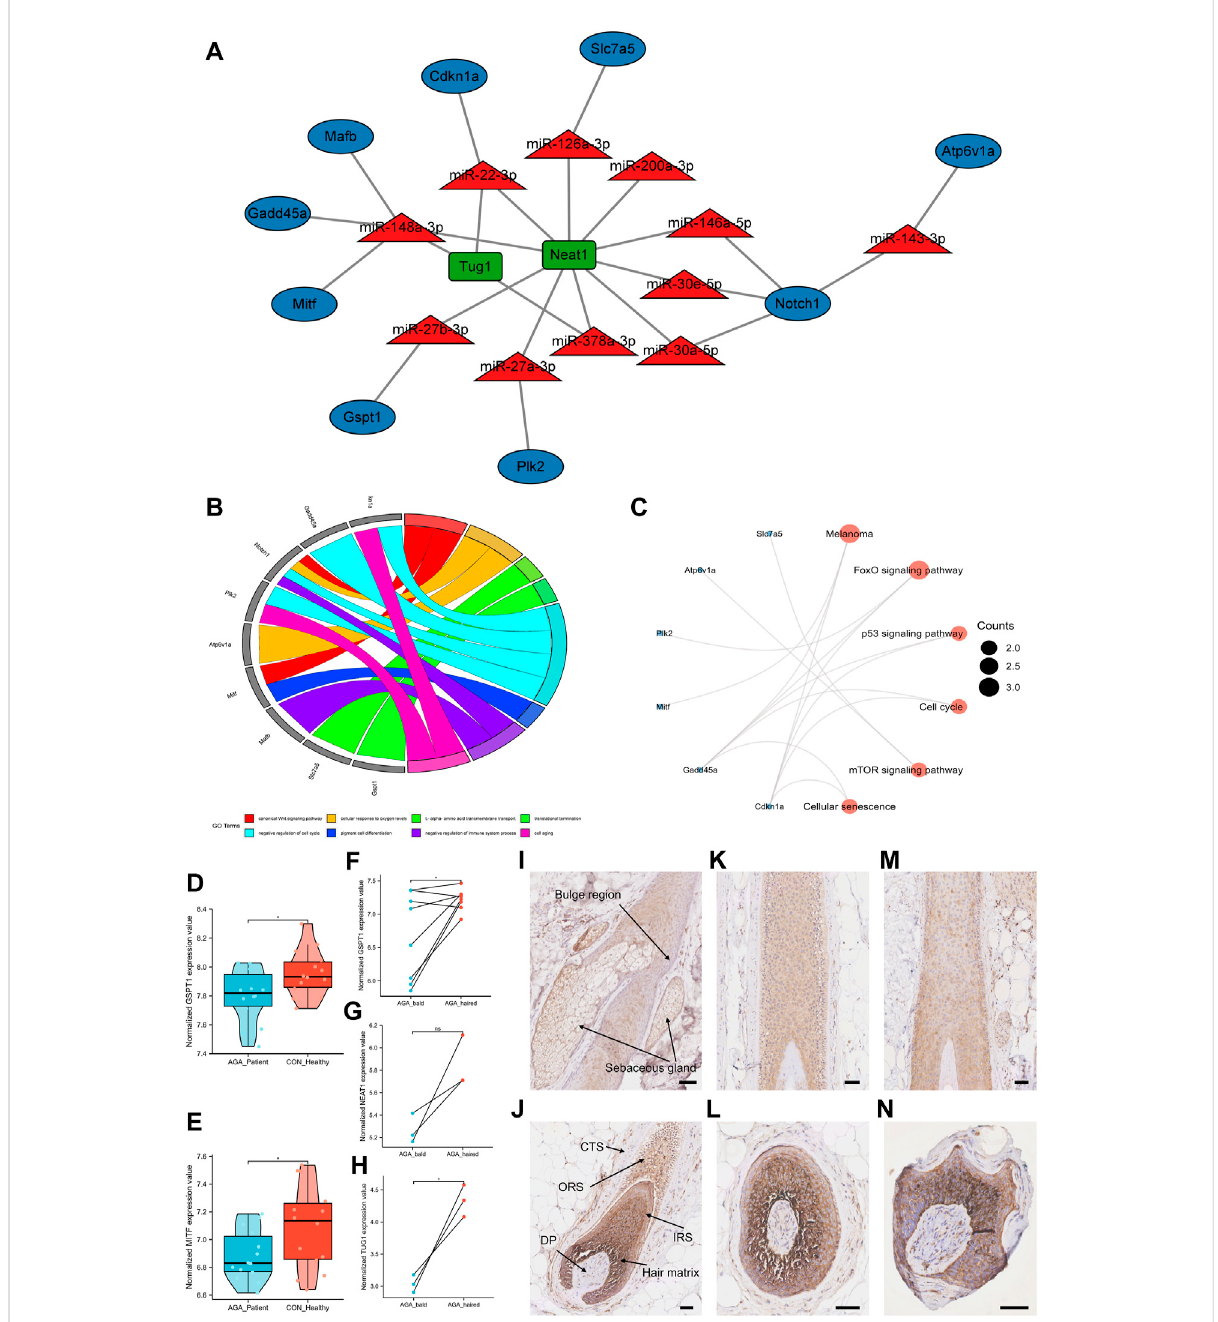
FIGURE 5 Construction of ceRNA networks of the hair follicle cycle and identi fi cation of novel alopecia-related target genes. (A) Construction of ceRNA networks inthemurinehair folliclecyclebasedon theidenti fi edandPCR-validated genes. (B) GObiologicalprocesses enrichmentanalysis oftarget mRNAs in the ceRNA networks. (C) The KEGG pathway enrichment analysis of target mRNAs in the ceRNA networks. (D,E) The expression of target genes GSPT1 and MITF in AGA patients and healthy individuals. (F – H) The expression of target genes GSPT1 , lncRNA TUG1, and lncRNA NEAT1 between bald and haired groups in AGA patients. (I – N) GSPT1 immunostaining (brown) with blue purple nuclear counterstain in the scalp tissueofhealthyindividuals (I – L) andthebaldscalpofpatientswithAGA (M,N) .AnagenfolliclesofhealthyscalphavestrongstainingforGSPT1inhair matrix and IRS, medium level in ORS, and low/undetectable staining in the bulge region: DP and CTS. Low GSPT1 expression was observed in upper IRS and ORS of miniaturized hair follicles from the AGA scalp. Scale bars, 50 μ m ns, p ≥ 0.05; *, p <